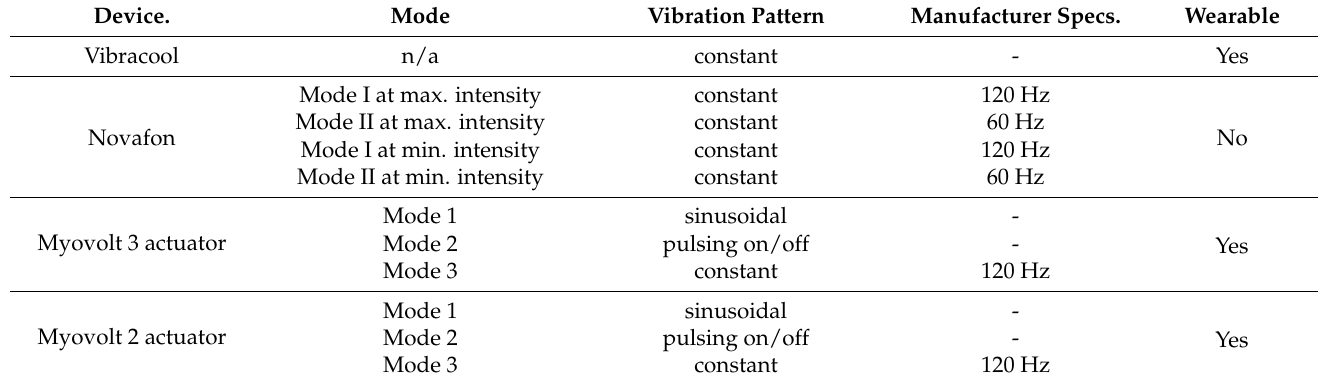
Table 1. List of devices and modes used. Not all specifications have been provided by the manufacturers. Novafon frequency data [29] and Myovolt frequency data [30] are from their respective websites. Device. Vibration Pattern Manufacturer